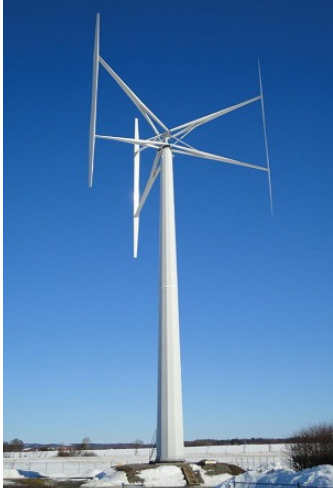
Figure 2. The three bladed 200 kW vertical axis wind turbine in Falkenberg,